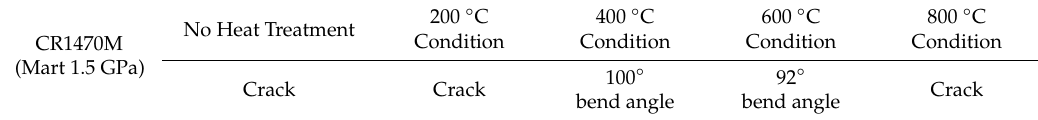
Table 2. Results of the